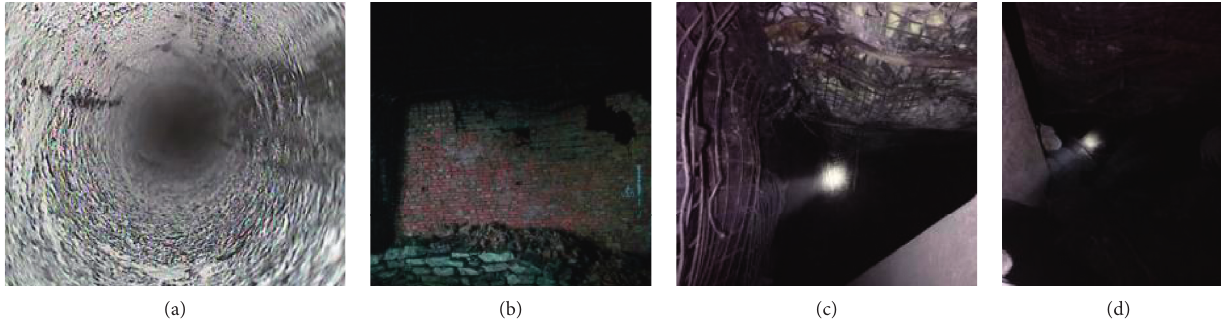
Figure 2: Strata behaviours: (a) internal conditions of the corner roof, (b) deformed enclosed wall, (c) suspended roof at the upper corner, and (d) bending and sinking lower corner.